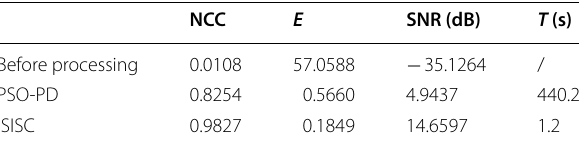
Table 2 Quantitative evaluation of the charge–discharge‑ like noise processing